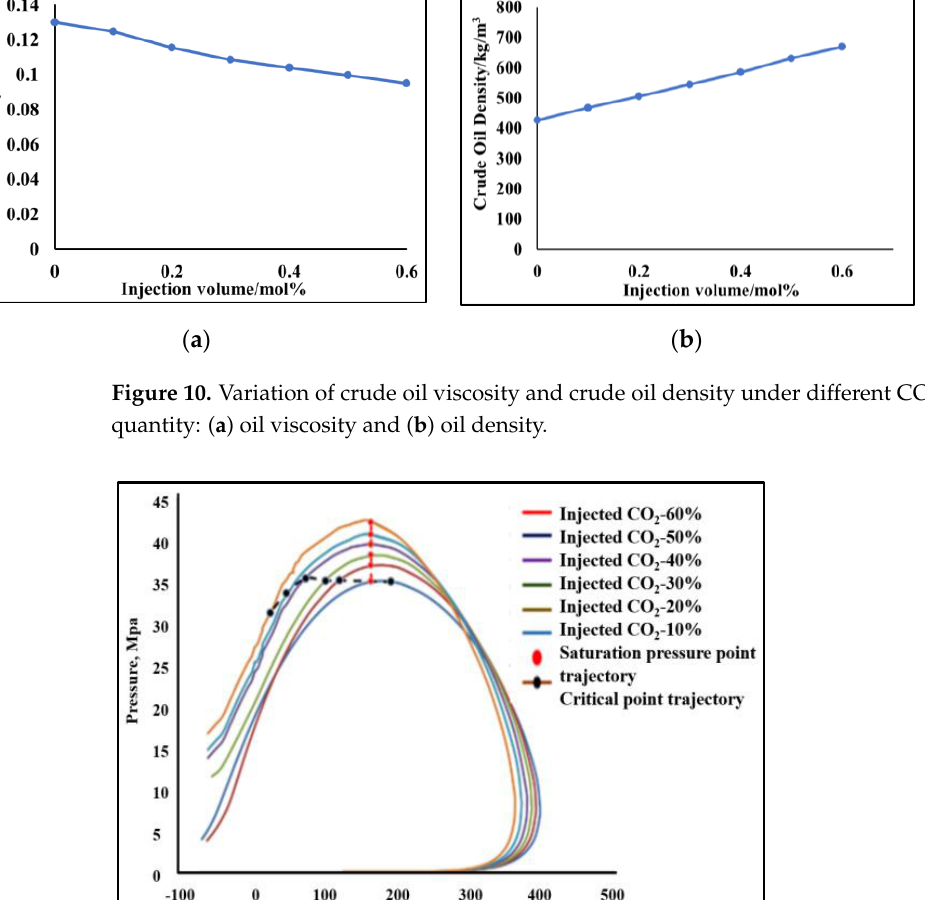
Figure 11. P-T of the system with different CO 2 injection molar quantity.